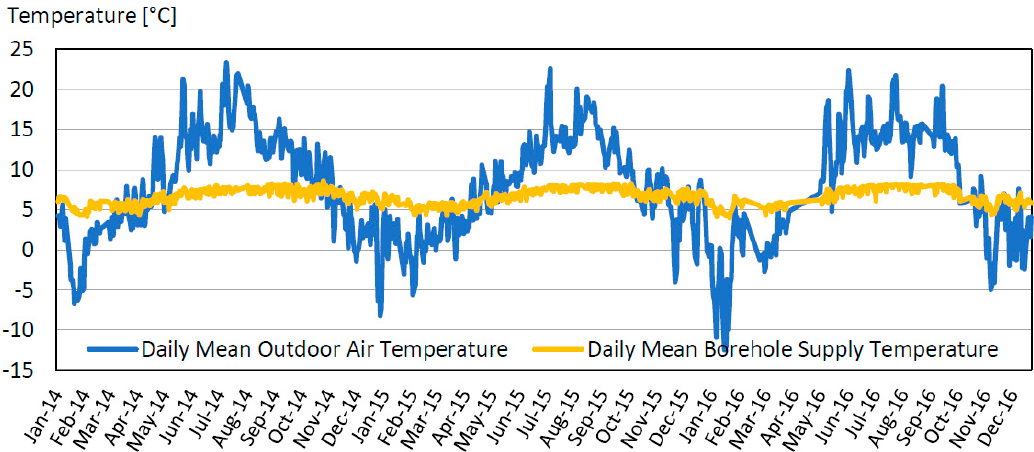
Figure 8. Measured daily average outdoor air and ground heat exchanger exit fluid temperatures.